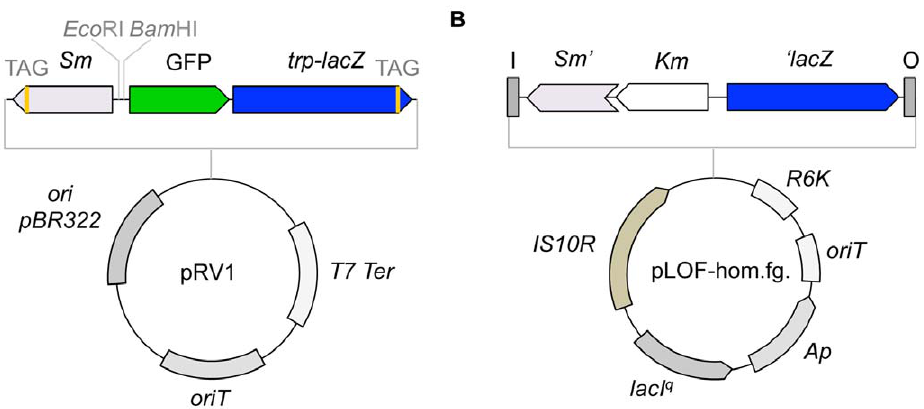
Figure 1. Bicistronic reporter system based on GFP and lacZ . A The reporter vector pRV1 containing truncated versions of the lacZ gene and Sm/Sp resistance marker could only be maintained in E. coli strains with supF tRNA. GFP is located upstream of the lacZ gene and is preceded by the Eco RI/ Bam HI cloning site for the target promoters. The oriT sequence allows the mobilization of pRV1 to new hosts by conjugation. B The mini-Tn10- based vector pLOF-hom.fg. was used for target strain modification. This vector contains the homologous fragment, which was introduced into the strains of interest to create single copy insertions in the chromosome.